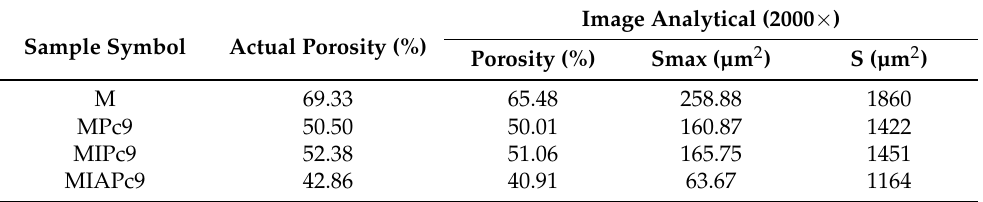
Table 4. Quantitative pore characteristics of different samples (Smax: maximum pore area; S: total pore area).